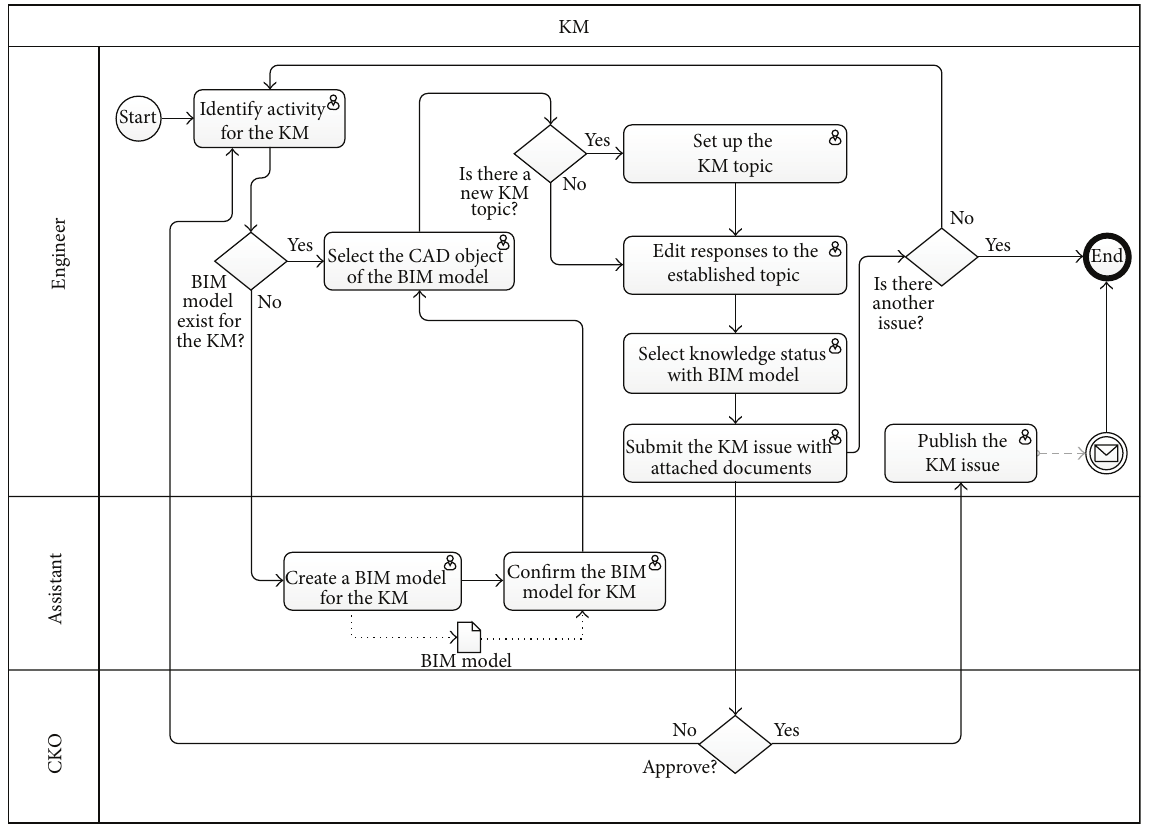
Figure 4: The BIM-based knowledge sharing and management process